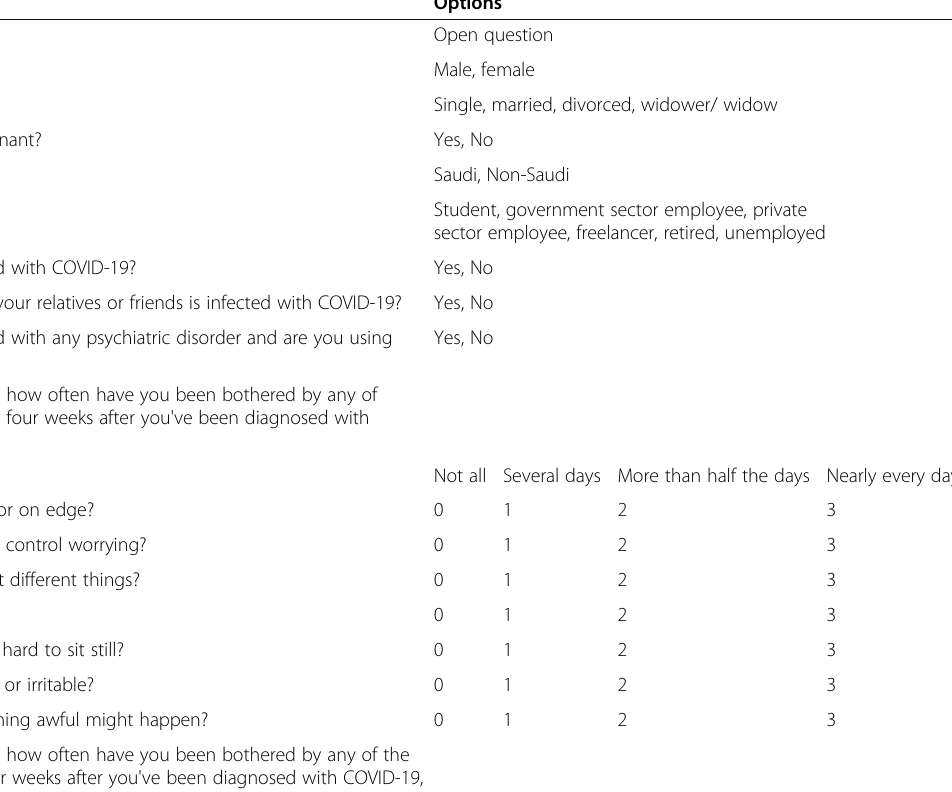
Table 1 Questions about demographic data and medical history. PHQ-9 Patient Health Questionnaire-9 and GAD-7 General Anxiety Disorder-7 that are included in the